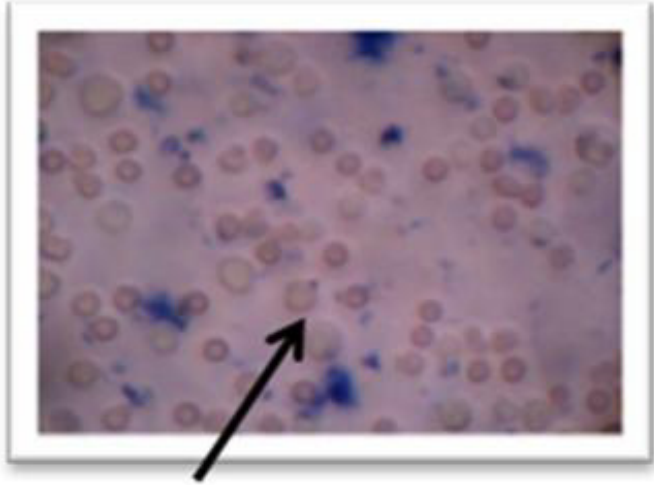
FIGURE 5 - Mononuclear cells stained with Tripan blue cell viability of 98% (incolor